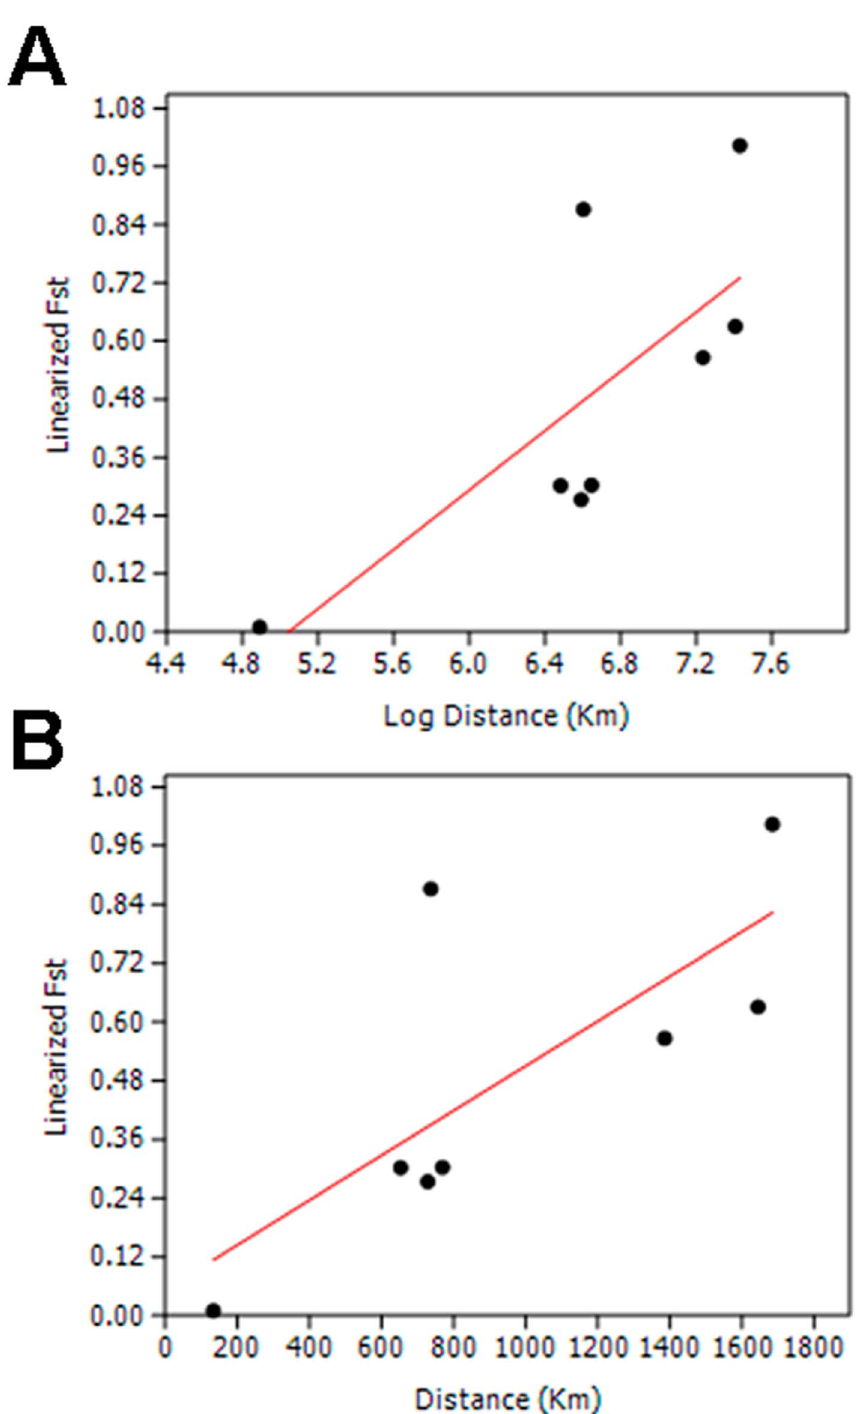
Figure 2. Regression analysis of pairwise linearized Fst regressed on natural logarithm geographic distances between P.vivax populations in Thailand (A) and pairwise linearized Fst regressed on geographic distances between populations (B).